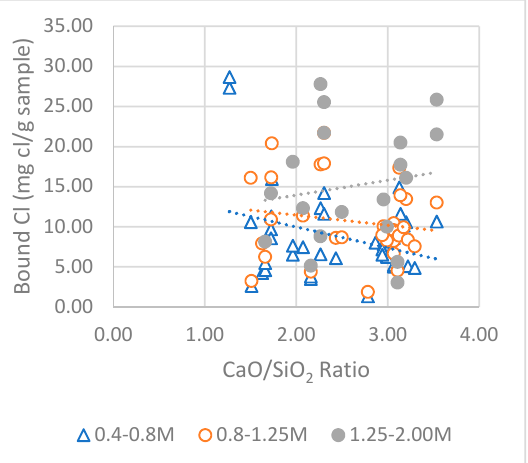
Figure 11. Relation between Al 2 O 3 ratio and bound chloride for different chloride concentrations for all data.